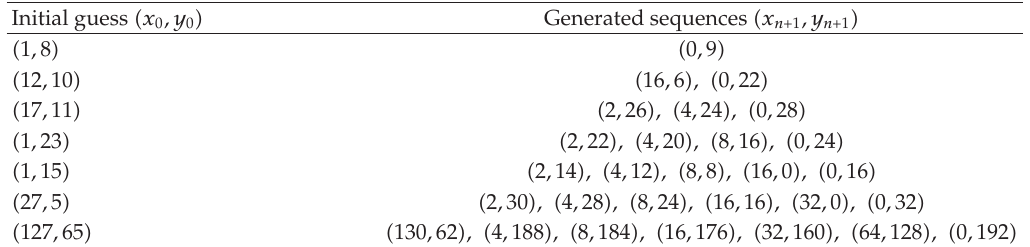
Table 3: Generated sequences of CVT and XOR